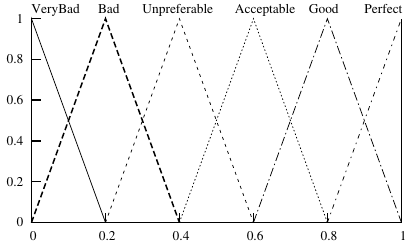
Figure 3. Output membership